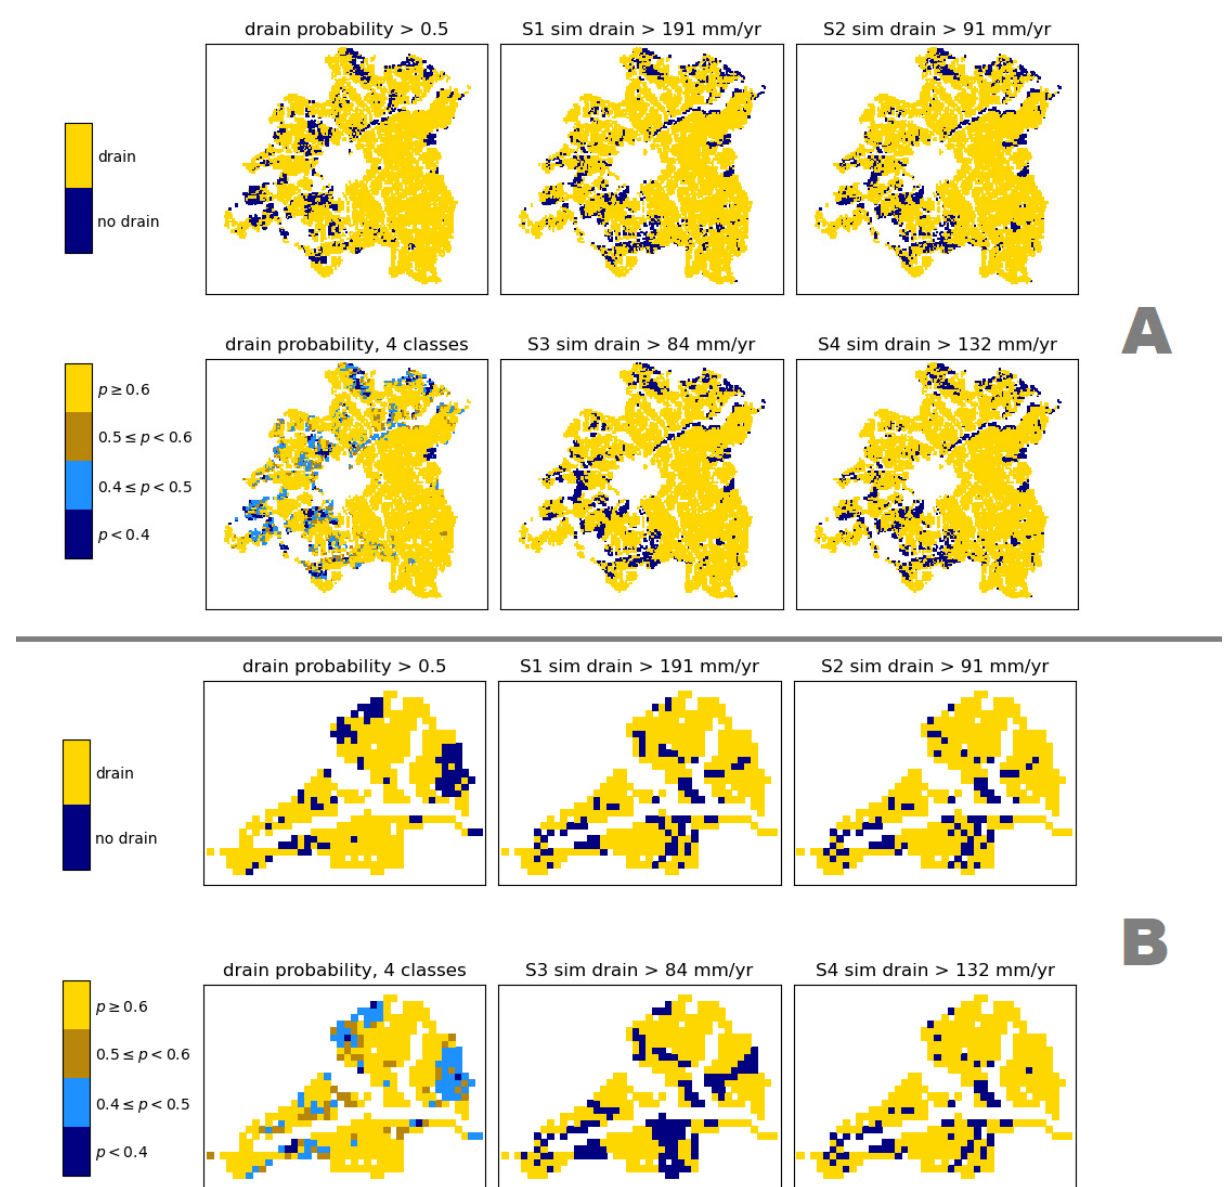
Figure 7. Distribution of simulated drain from the different calibration scenarios in comparison to the drain probability map. ( A ): Norsminde. ( B ): Fensholt sub-catchment. The top right maps of both A and B show drained areas according to the drain probability map, and the bottom right maps of both A and B show the same drain probability in 4 classes. The other maps display drained and undrained areas as resulting from the simulations in the four scenarios. The simulated drain threshold given in the titles is calculated to match the total area of drain probability larger than 0.5.